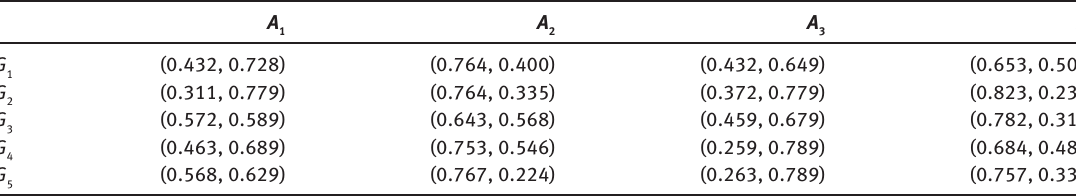
Table 9: Collective Pythagorean Fuzzy Decision Matrix R .